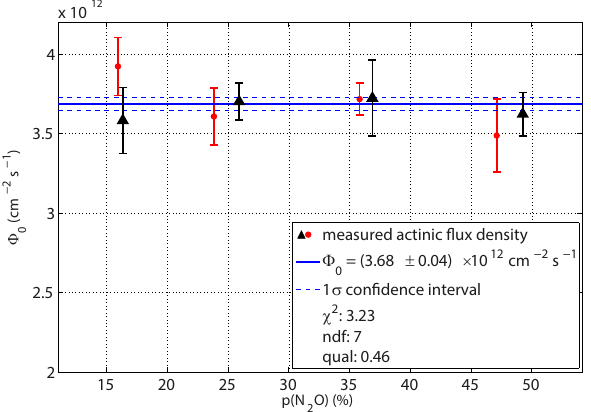
Figure 2. Sensitivity change inside the second detection axis of HO- RUS as a function of the associated laser scatter signal. A linear correlation ( R 2 = 0 . 96) with a non-significant offset was observed during instrument calibrations. The functional dependency obtained from linear regression was applied to the measurements to correct for changes in instrument sensitivity by continuously monitoring the laser scatter signal. A similar correction function for the change in sensitivity of the first detection cell has also been determined em- pirically and